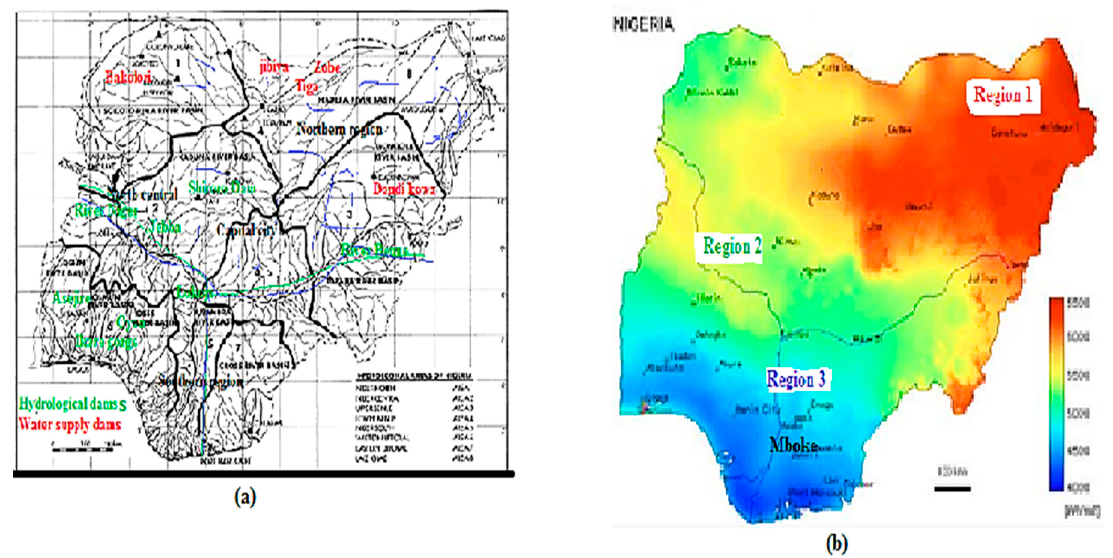
Figure 1. Map of Nigeria. ( a ) Hydrological river basins; ( b ) Solar radiation and solar electricity potential. Reproduced from references [37,38].